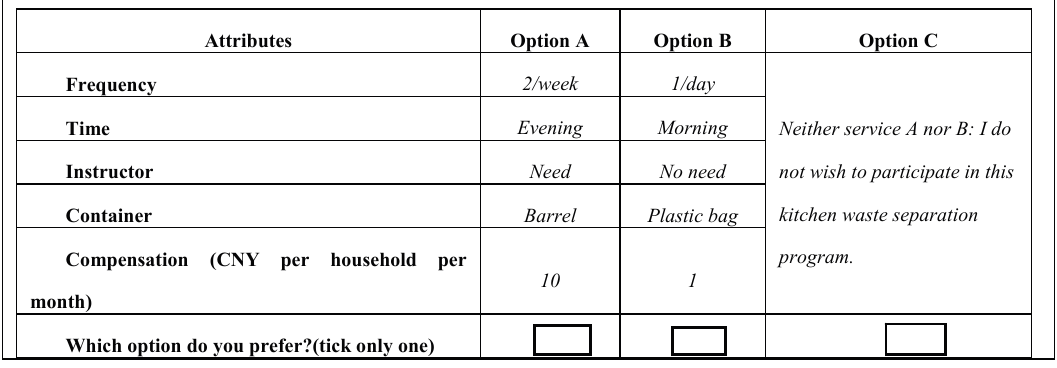
Figure 1. Example of a household kitchen waste separation services choice